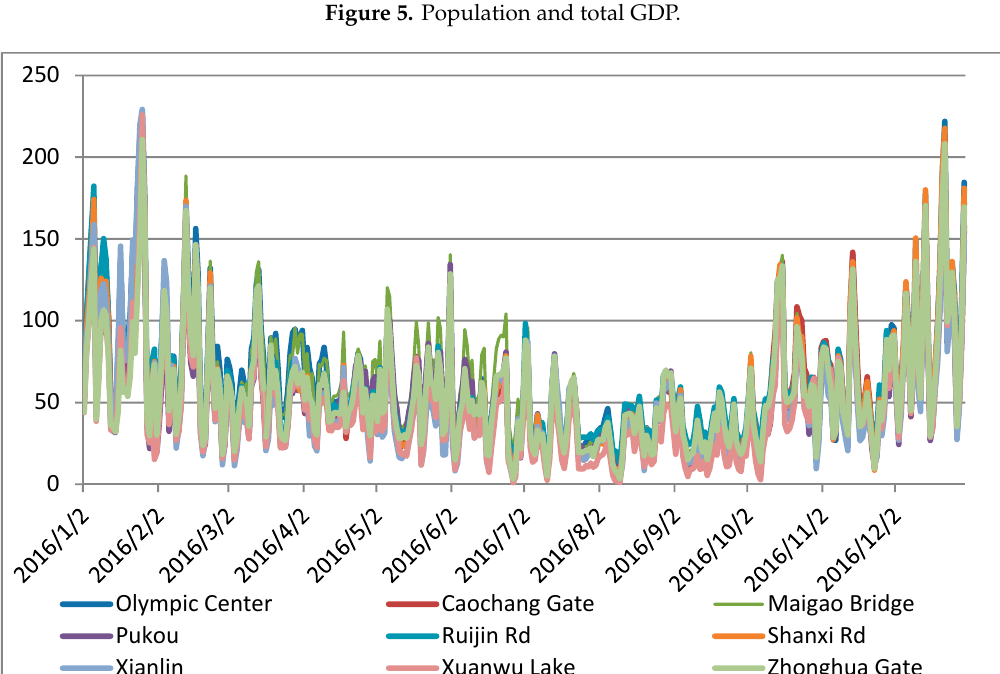
Figure 6. Value of PM2.5 of each site in 2016 unit: μ g/m³.